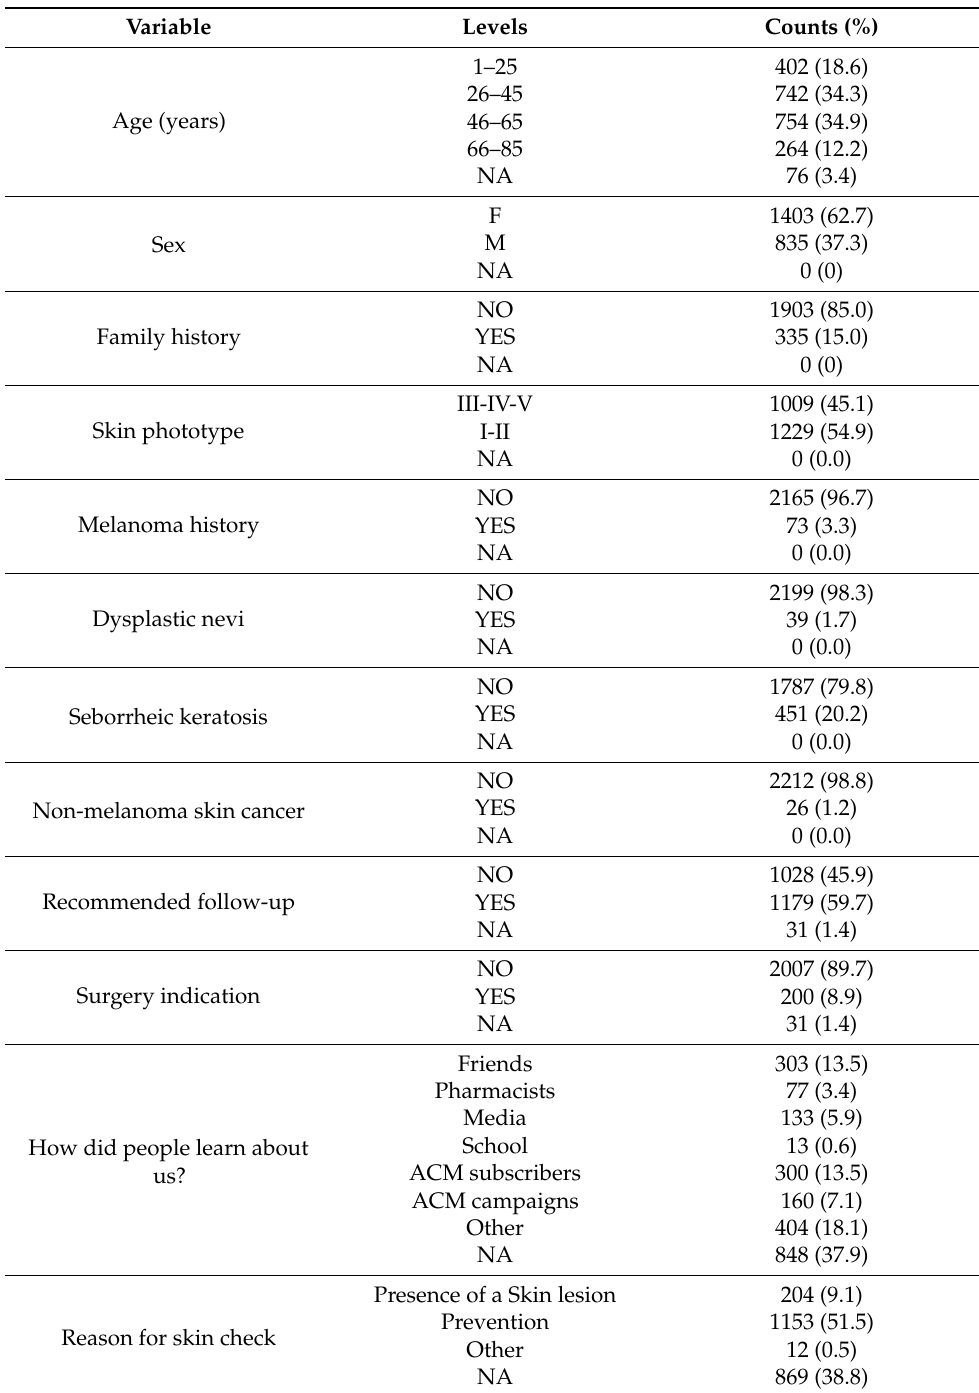
Table 1. Patient characteristics, including recommendations of periodic skin checks or surgical removal of suspicious lesions, source of information of the campaign activities, and reasons to undergo skin check. NA, missing data (not